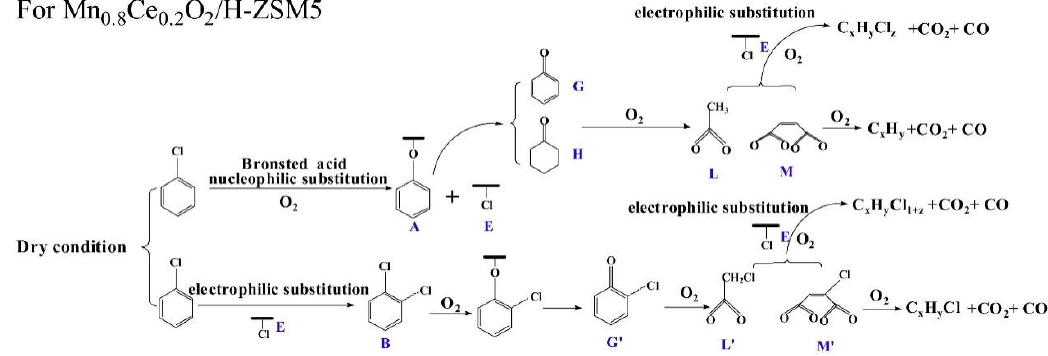
Figure 2. Degradation mechanism of CB literature [37]. Copyright 2016, Elsevier B.V.